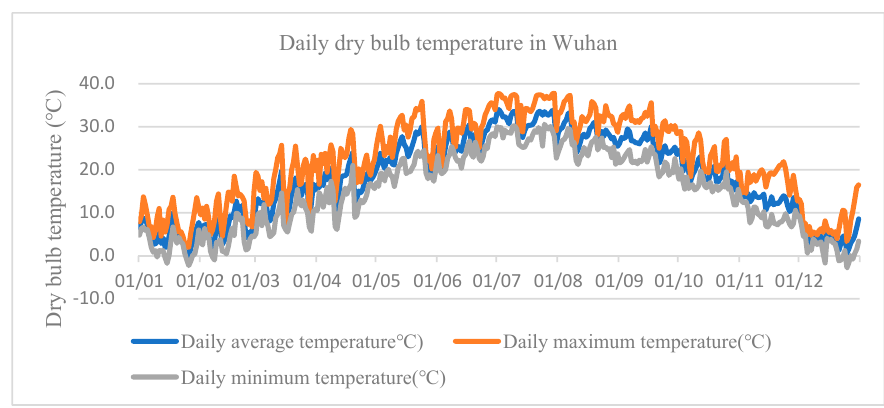
Figure 4. The statistics of daily dry bulb temperature in Wuhan [31]. In July, solar radiation peaks, with 650 MJ/m 2 , as shown in Figure 5, for total monthly solar radiation.